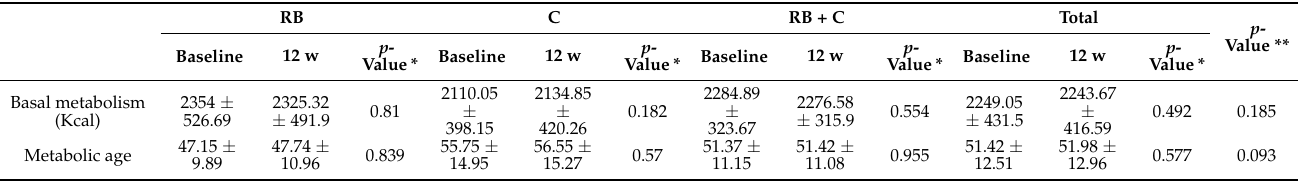
Table 2. Metabolic parameters in each group and by visit.